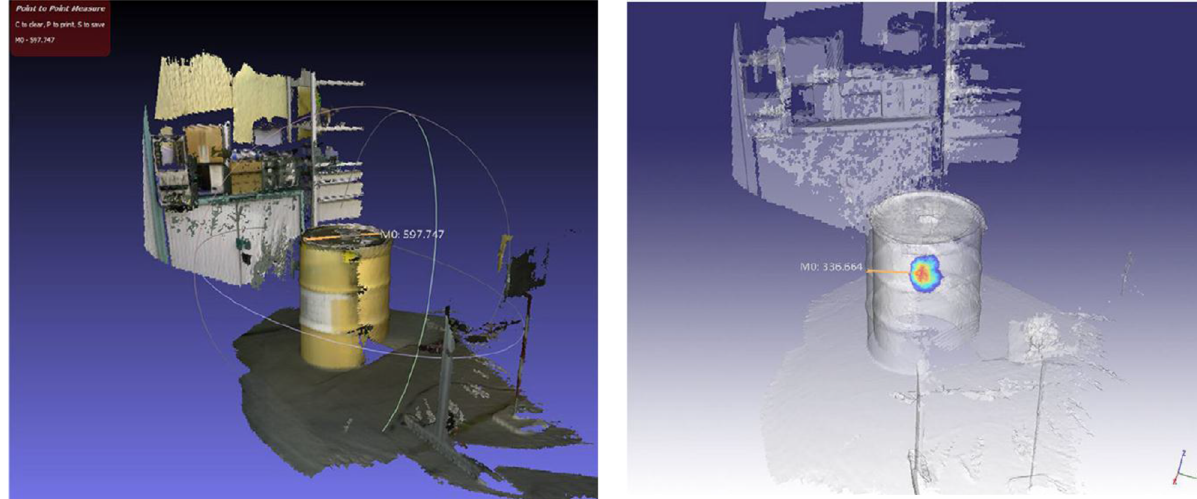
Fig. 1. Illustration of the capability of a stereo g -camera to locate a 137 Cs source placed inside a barrel with an outer diameter of 60cm, taken from Paradiso et al.